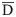
Absolute allele frequency difference averages of shared SNPs of R. montenegrensis and R. robustus per transcript (D¯).We highlight in red the class of SNPs with D¯ = 1.